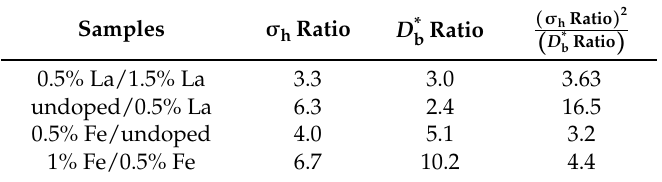
Table 2. Ratios of conductivities and tracer bulk diffusion coefficients at 560 ◦